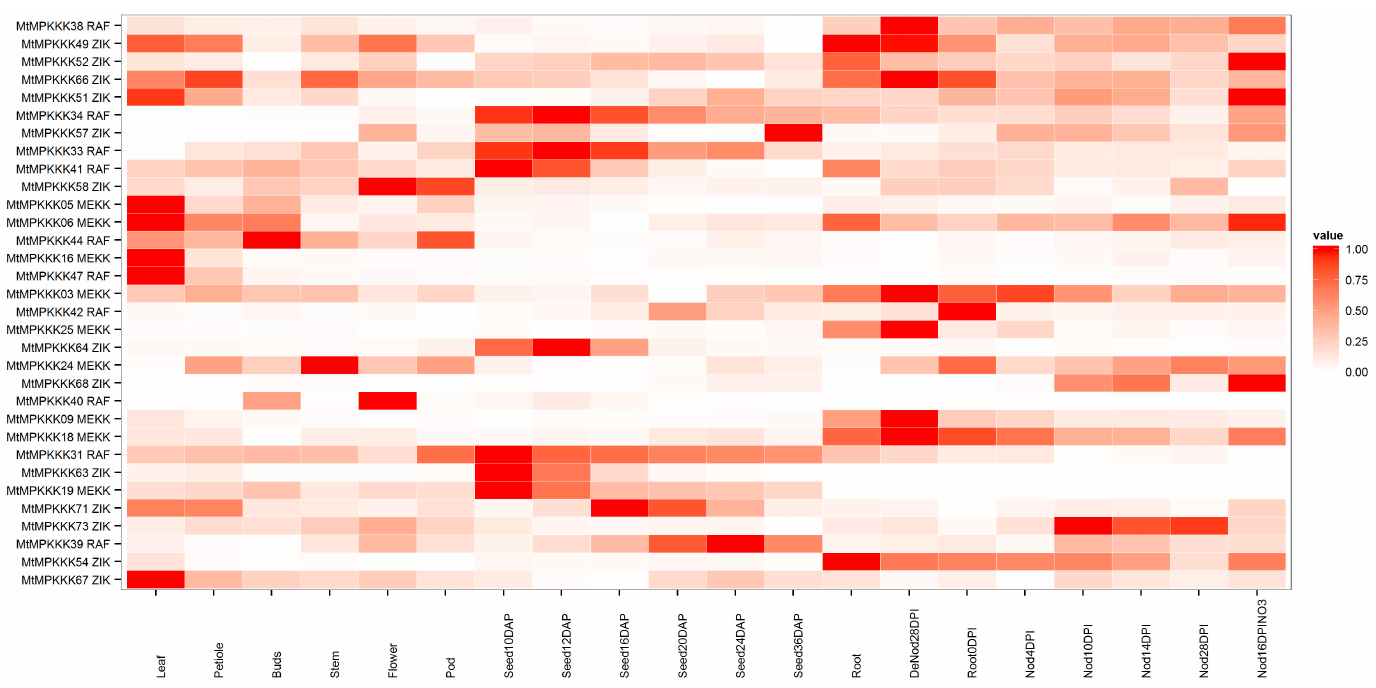
Figure 4. Expression profile cluster analysis of MtMAPKKK genes involved in growth and development. The expression data were clustered and displayed using software ggplot2. The DAP infers days after pollination, while DPI infers days after inoculation; the information on samples is from Benedito et al. [30].